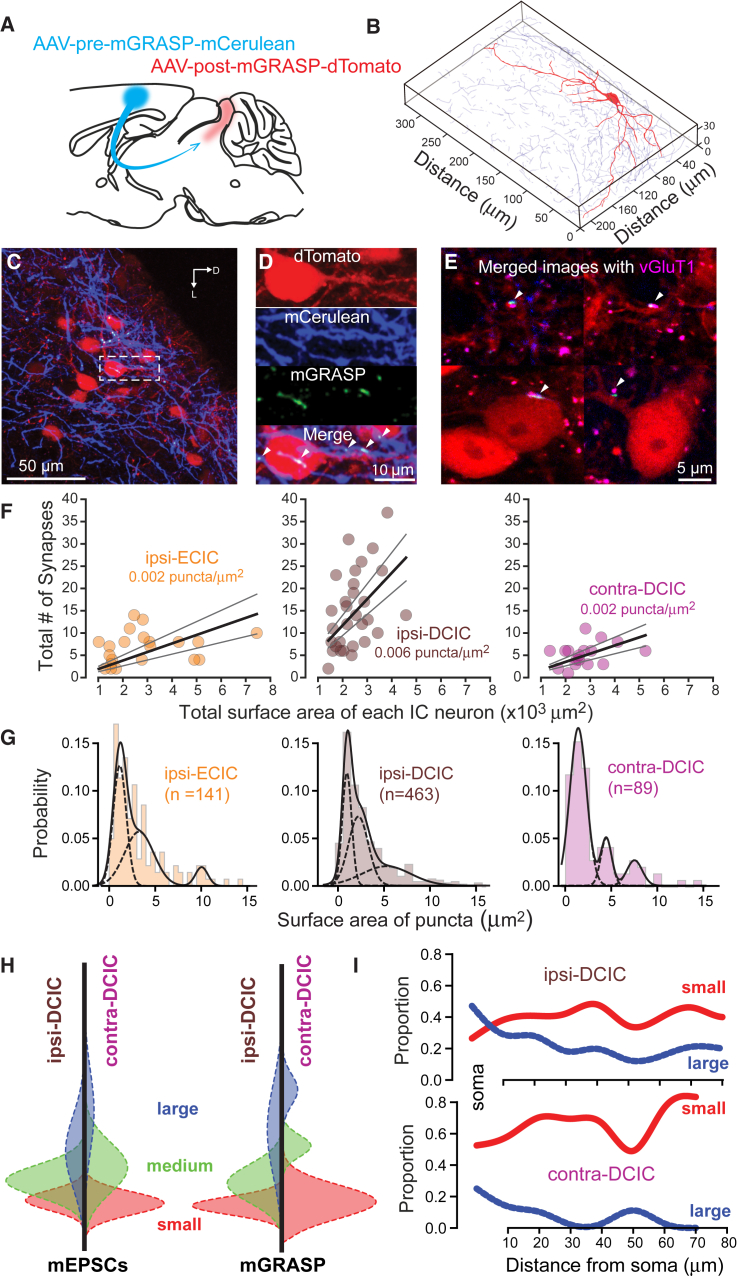
Correspondence of Anatomical and Functional Distributions of Small, Medium, and Large Synapses across the Somatodendritic Axis of Ipsi- and Contra-DCIC Neurons(A) Schematic demonstrating the unilateral injection of the pre-mGRASP viral vector into the AC and bilateral delivery of the post-mGRASP viral vector into the IC.(B) 3D reconstruction of a postsynaptic IC neuron (red) and the presynaptic mGRASP signal in the dorsal region of the contra-DCIC.(C) Exemplar confocal image from the ipsi-DCIC. Post-mGRASP-labeled IC neurons (red) are shown, along with pre-mGRASP-labeled axons (blue) projecting from the AC. The dashed box indicates the region of this image that is shown at higher magnification in (C) to identify the mGRASP signals (green).(D) Blue, red, and green channels are separated to illustrate the location of the presynaptic CC axons (blue), the postsynaptic IC neuron (red), and the GFP-labeled mGRASP signals (green). The bottom image is the merger of the three images above.(E) Four merged images similar to the bottom image in (D) but containing a purple stain for VGluT1.(F) Scatterplots showing the total number of mGRASP synapses identified on each neuron (filled circles) in relation to the surface area of each fully reconstructed neuron. The solid lines show the results of linear regression analysis for the data obtained in the ipsi-ECIC, ipsi-DCIC, and contra-DCIC. The dashed lines are the 5% and 95% confidence limits for these fits.(G) All-point histograms illustrating the probability density functions for mGRASP puncta of varying sizes within the ipsi-ECIC, ipsi-DCIC, and contra-DCIC.(H) Mirrored probability density functions of small (red), medium (green), and large (blue) synapse distribution in ipsi-DCIC (left) and contra-DCIC (right) assessed via mEPSC amplitude (left-hand plots) or mGRASP puncta surface area (right-hand plots).(I) Location of small and large synapses across the somatodendritic axis of DCIC neurons. Ipsilateral CC connectivity to the IC (ipsi-DCIC) is characterized by an increased proportion of large proximal synapses compared to contralateral CC (contra-DCIC).